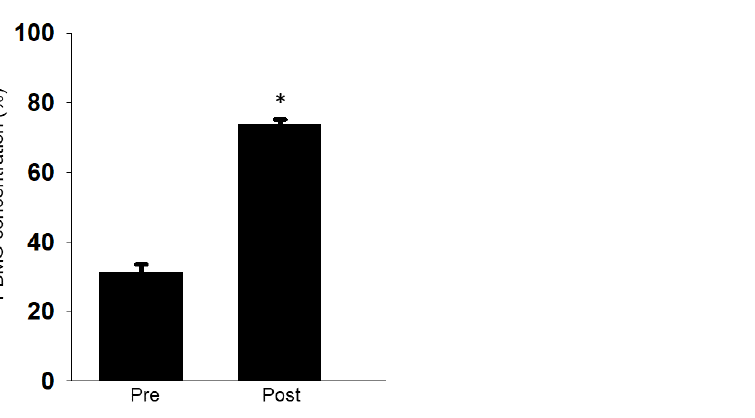
Figure 4. Collection efficacy of PBMCs by apheresis. PBMC concentration pre-apheresis (Pre) and post-apheresis (Post) was calculated. Results were expressed as mean ± S.E.M ( n = 3). ∗ p < 0.05 vs. Pre.